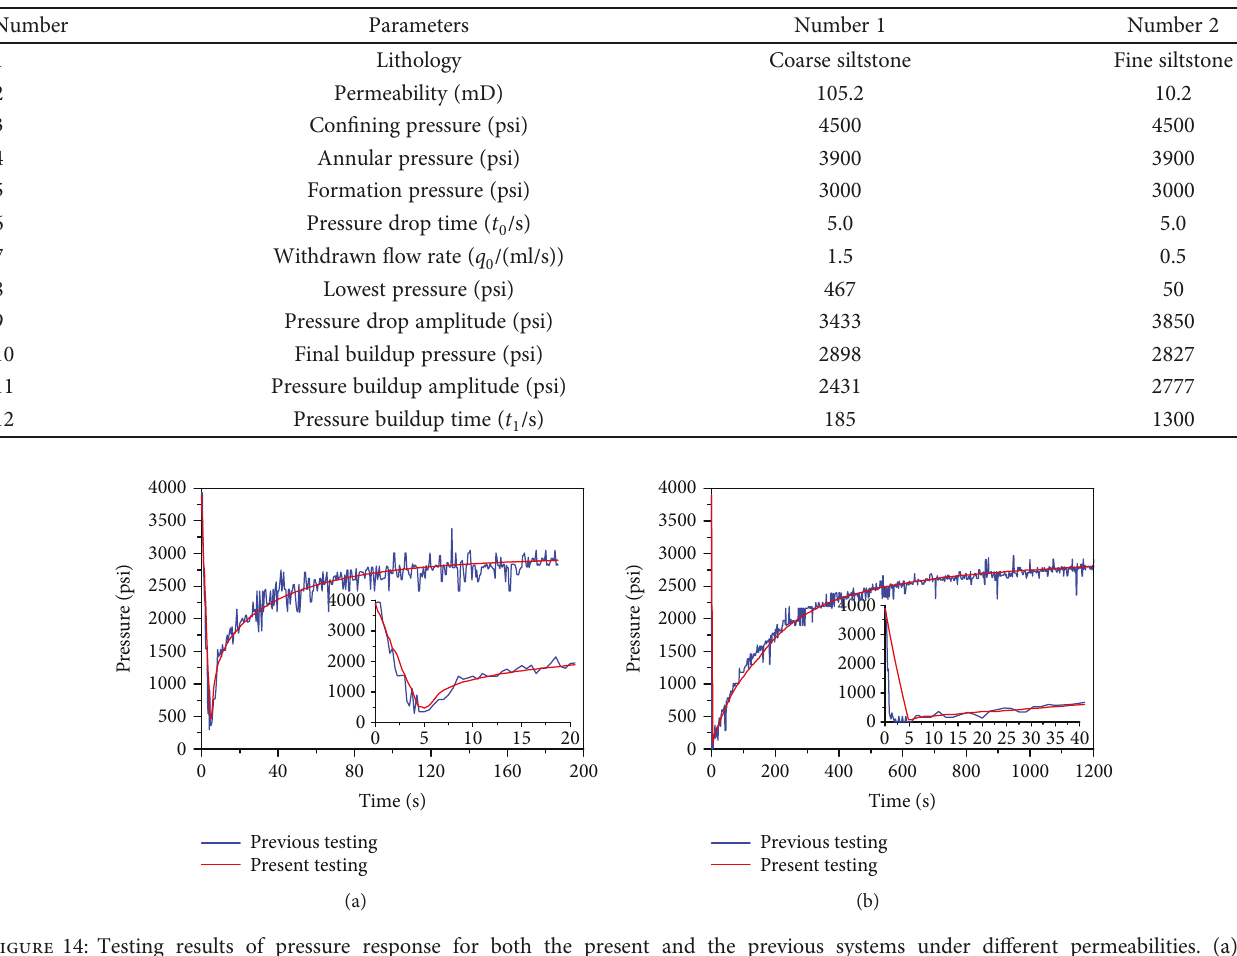
Table 2: Experimental results.